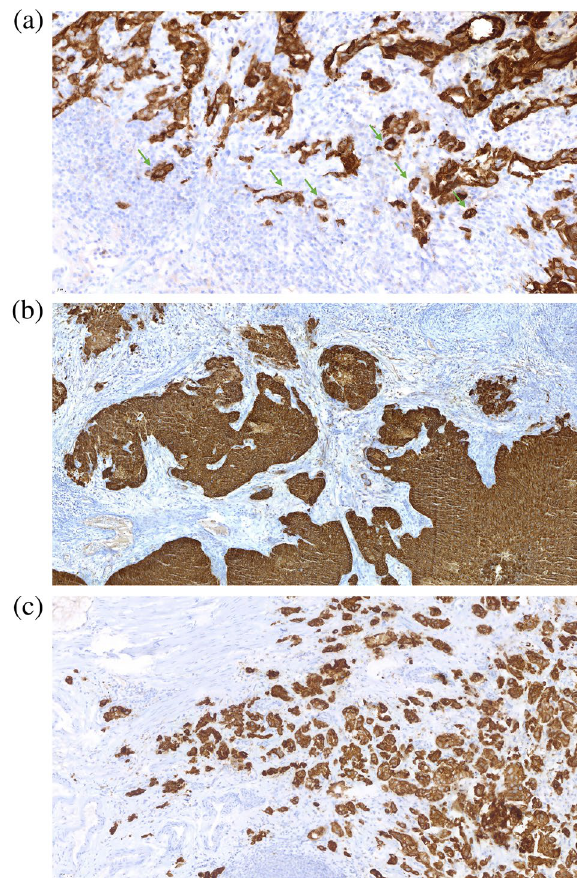
Figure 1. Examples of ( a ) tumor budding at the invasion front (green arrows); ( b ) cohesive growth pattern; ( c ) discohesive growth